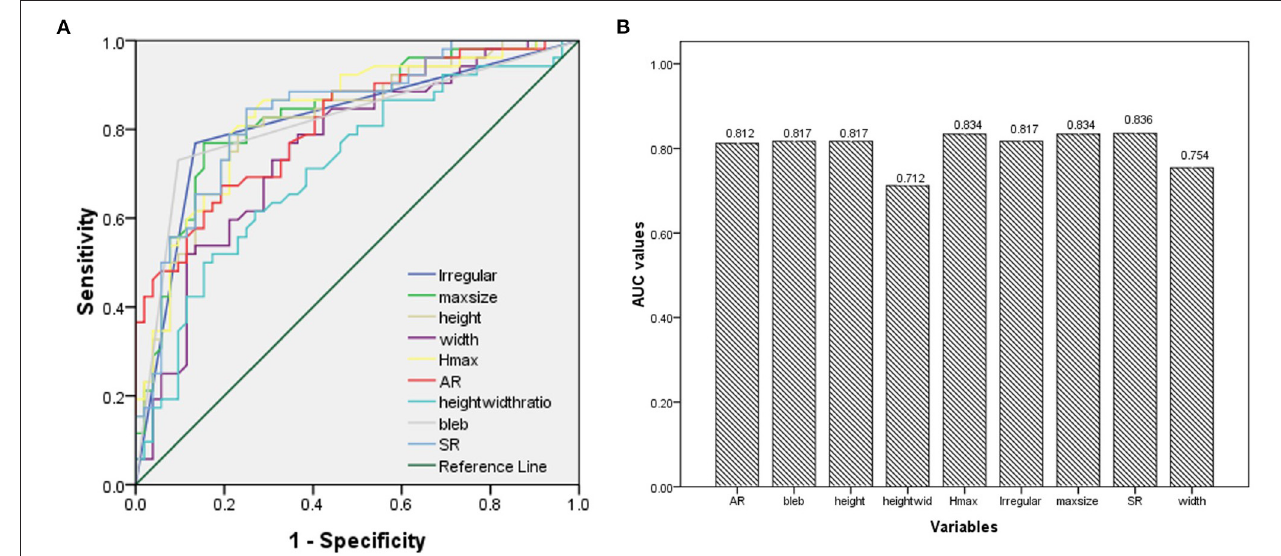
FIGURE 3 | (A) Results of the receiver operating characteristics (ROCs); (B) The area under the curve (AUC) values for key parameters.